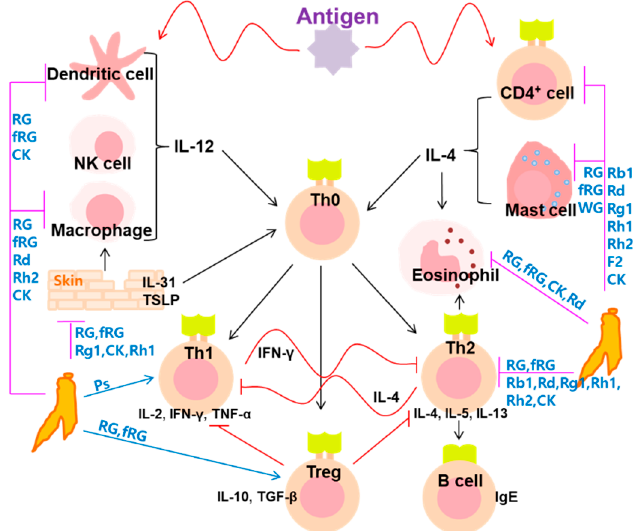
Figure 3. The hypothetical antiallergic action mechanisms of ginseng and ginsenosides. CK, compound K; fRG, fermented red ginseng; RG, red ginseng; WG, white ginseng.